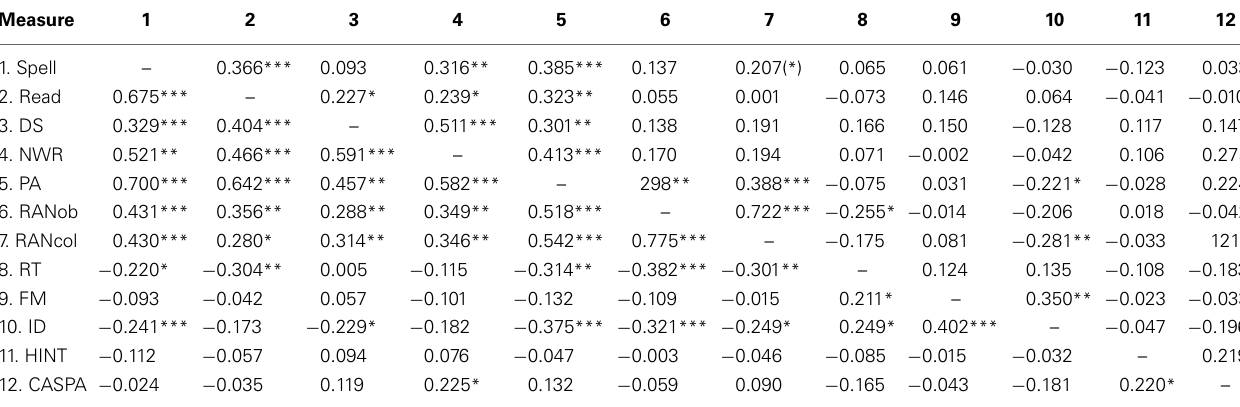
Table 4 | Correlations among measures for auditory processing, speech perception, phonology and literacy skills, with (upper part) and without (lower part) controlling for group.